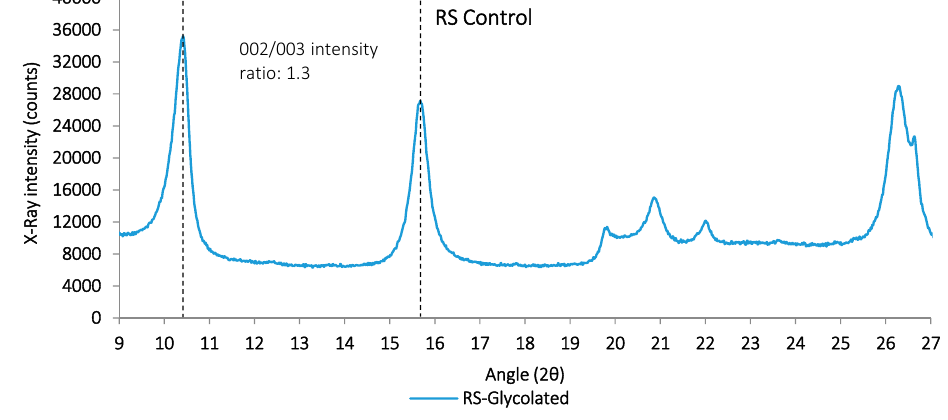
Figure 6. 002/003 intensity ratios for the RS ® control. Table 5. Fe content and intensity ratios for MX-80 with comparison of common smectite minerals [22]. Mineral Type